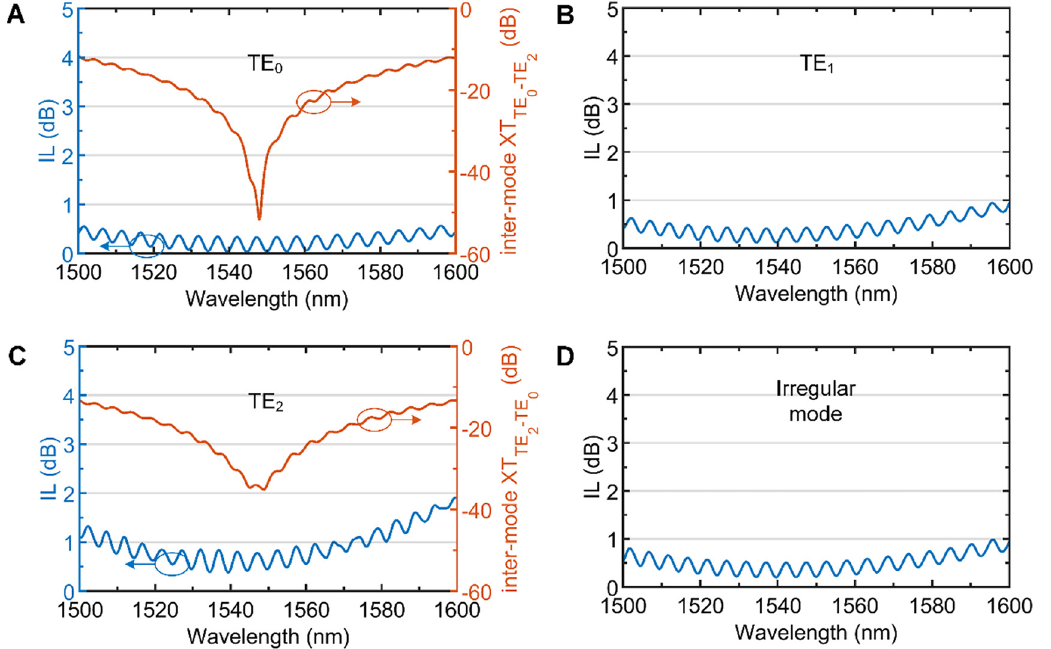
Figure3: InsertionlossandintermodecrosstalkspectrafortheAM-SSC.Theinsertionlossvaluesarecalculatedfor(A)TE 0 ,(B)TE 1 ,(C)TE 2 and (D) irregular incident modes. The intermode crosstalk values are calculated for (A) TE 0 and (C) TE 2 incident modes. SSC, spot size converter; AM, arbitrary mode; TE, transverse